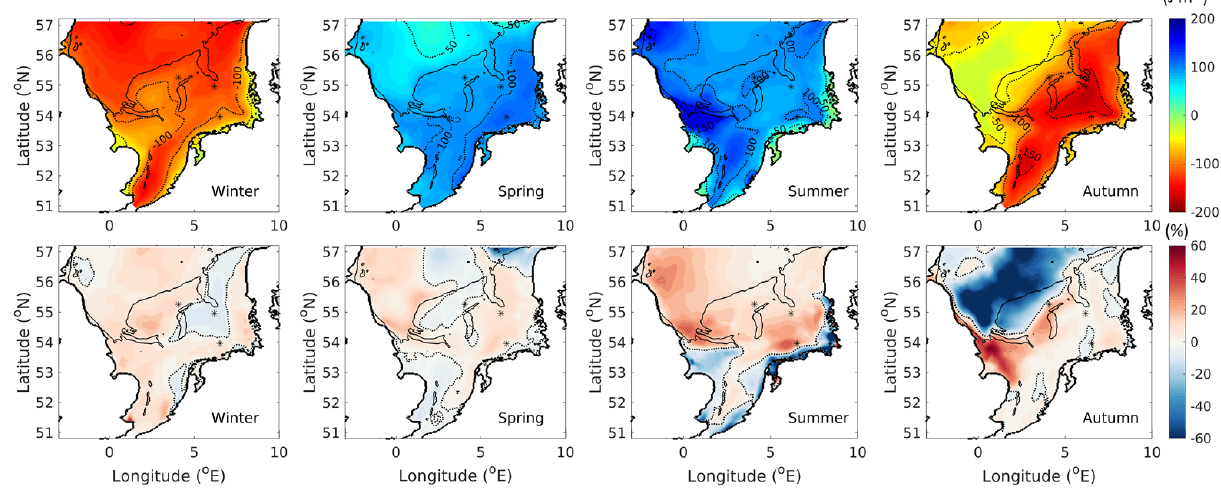
Figure 13. Same as Fig. 12, but for the surface heat fluxes. In the upper panels, positive values denote net fluxes from the air to the